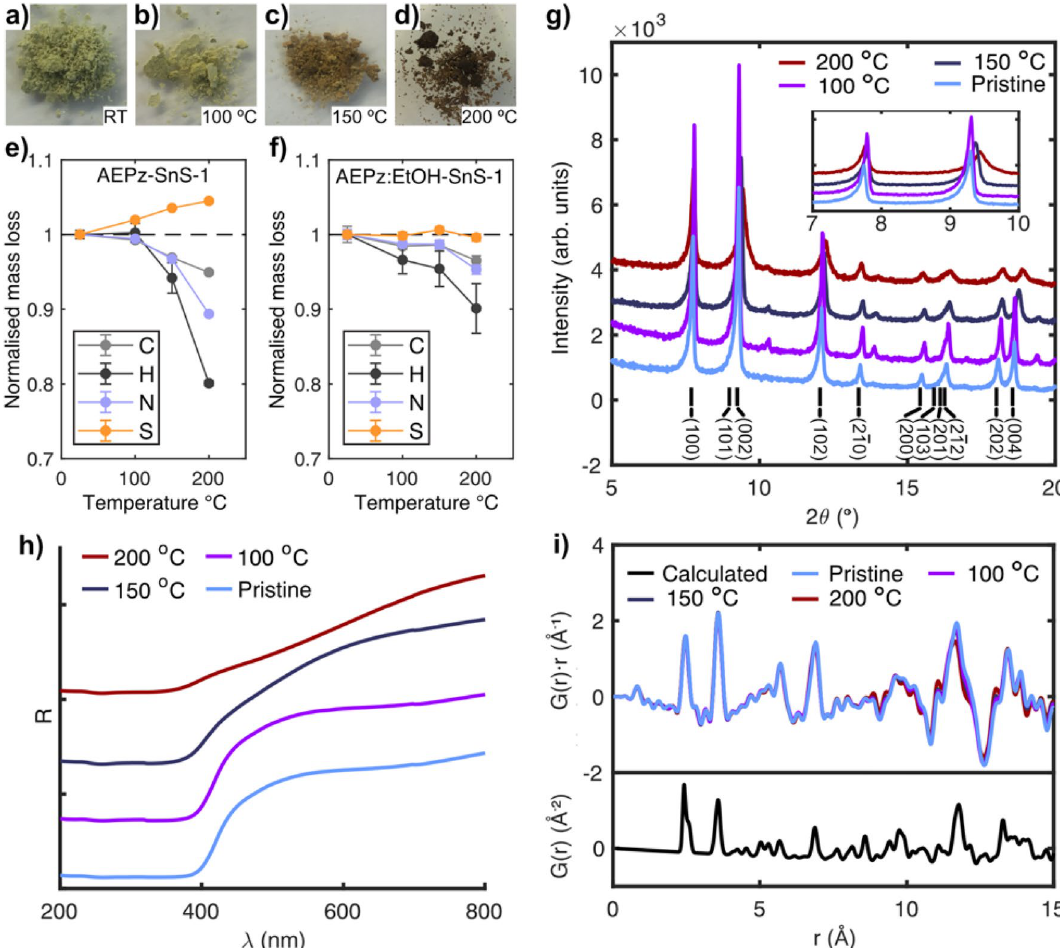
Figure 7. ( a – d ) AEPz-SnS-1 powder sample dried at room temperature (RT) and samples heated in air to target temperatures of 100 °C, 150 °C and 200 °C respectively. ( e – f ) CHNS analysis of AEPz-SnS-1 and AEPz:EtOH-SnS-1. Data are shown as weight fractions normalised to the respective pristine material. ( g ) PXRD data of all AEPz- SnS-1 samples with Miller indices based on CIF data. The insert is a zoom-in on the (100) and (101)/(002) peaks to highlight shifts in the diffraction angle and peak broadening of the (101)/(002) peak. ( h ) DRS data of the samples shown in ( a – d ). The spectra are shifted along the y-axis for easier comparison. No changes were observed at 100 °C. ( i ) PDFs of the heated samples of AEPz-SnS-1. G ( r ) is weighted by the correlation length ( r ) to highlight correlations at large distances in the experimental data. The calculated PDF of the pristine material is displayed as G ( r